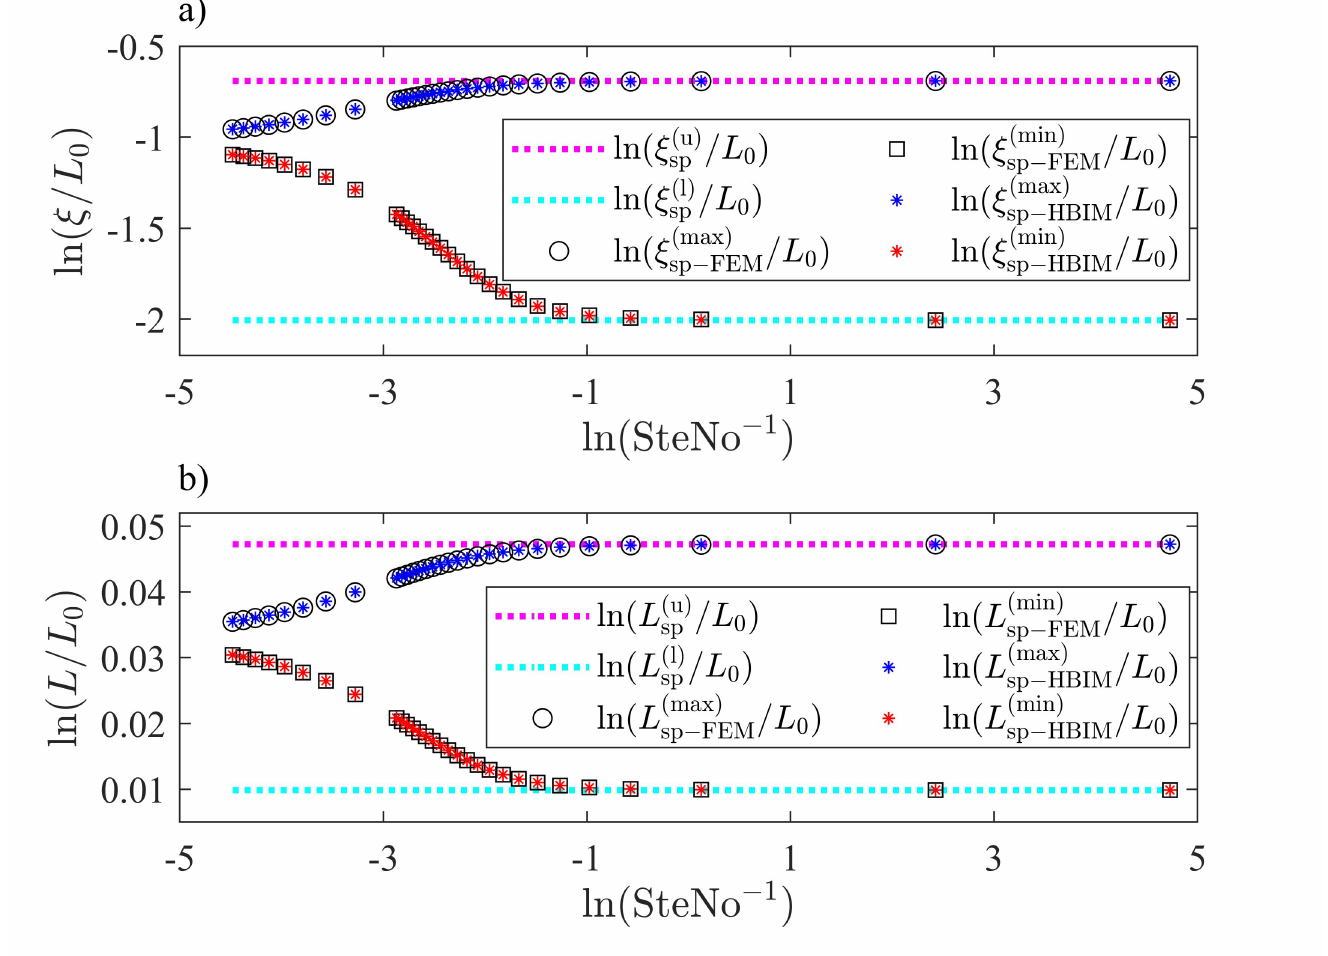
(cid:17) (cid:16) (cid:17) (cid:16) (cid:16) (cid:17) ( max ) ( min ) ( t ) / L ( t ) / L 0 ξ ξ SteNo − 1 for ln and ln , and ( b ) 0 1 1 (cid:17) (cid:17) (cid:16) L ( min ) ( t ) / L 0 and ln . Maxima and minima in ξ 1 ( t ) and L ( t ) were registered